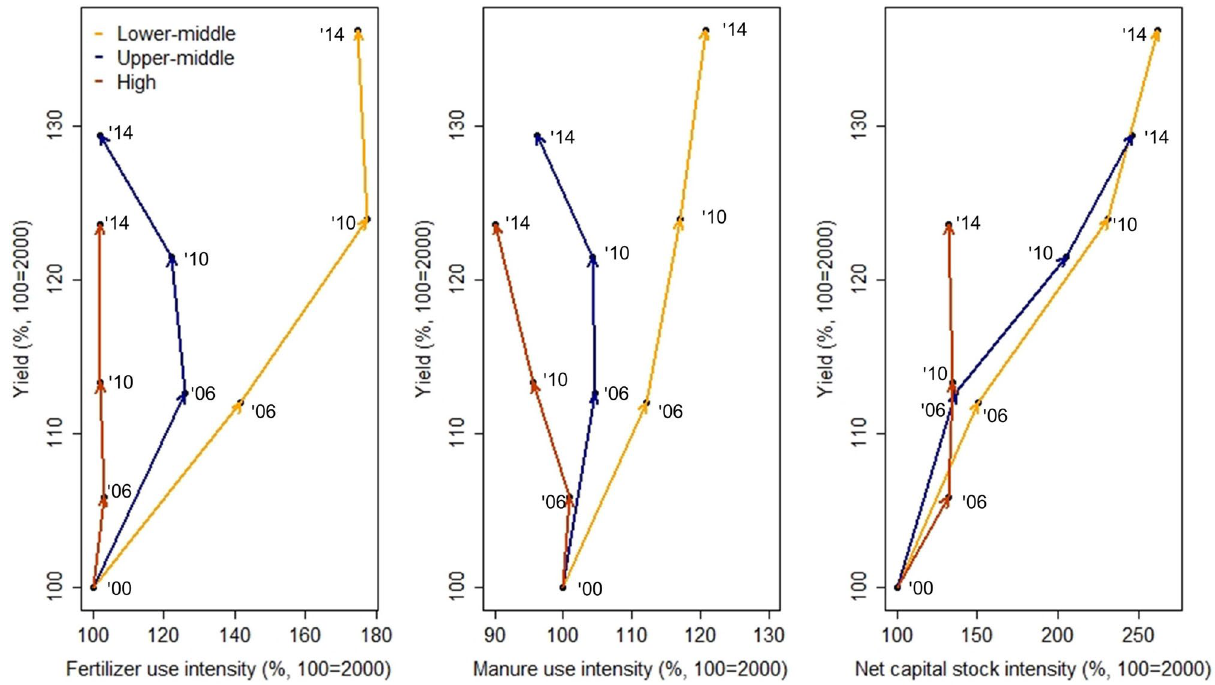
Figure 1. Trajectories of three anthropogenic coproduction factors for crop production in three Worldbank income classes (“lower-middle”, “upper-middle”, “high” income): fertilizer use intensity, manure use intensity and net capital stock intensity. Values are relative to the values in the year 2000 (100%). First arrow: 2000 to 2006, second arrow: 2006 to 2010, third arrow: 2010 to 2014. Yield increases over the years across income groups come along with stagnating or decreasing anthropogenic contributions in high income countries, and strong increase in net capital stock intensity in lower-middle and upper-middle income countries. Figure was created in R (version 3.6.1, https:// www.r- proje ct.